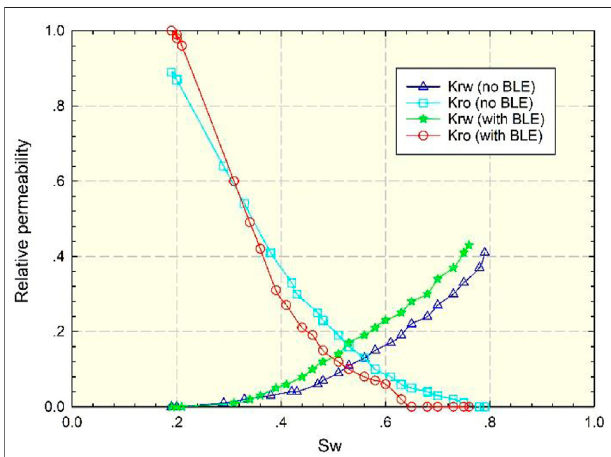
FIGURE 17 | Comparison of relative permeability with BLE.